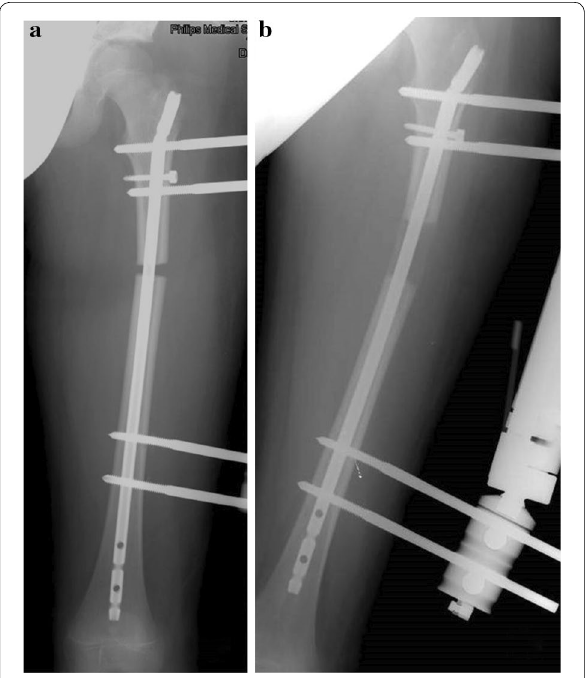
Fig. 3 a , b The same patient as illustrated in Fig. 2. The left femur was elongated over an intramedullary nail according to Paley